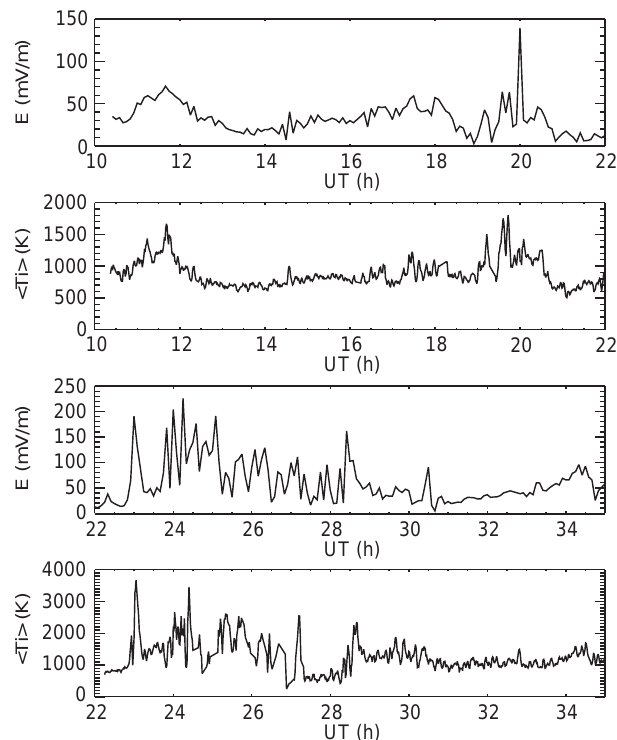
Fig. 1. Time series for 9–10 April 1990, of the electric field measured tristatically at 278 km altitude every 5 min and of the 1-minute average parallel ion temperature between 140 and 160 km altitudes using the of the E (cid:2) B drift sampled by the remote stations